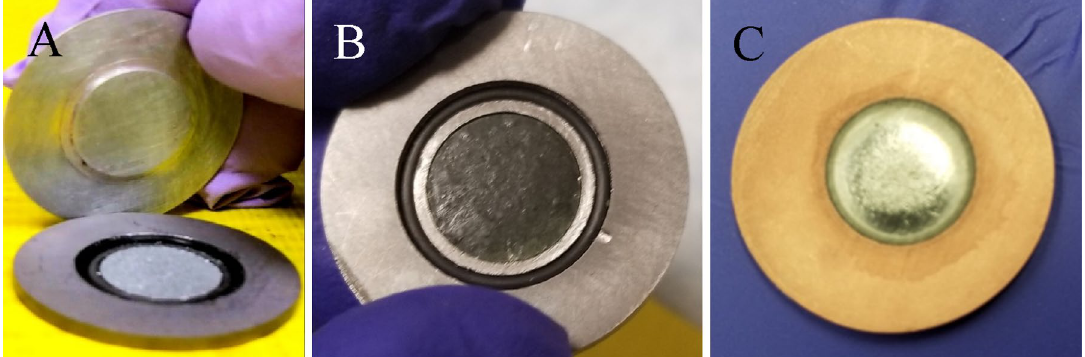
Figure 1. Photos of target configurations described before irradiation. ( A ) Cr metal powder target with Al “push button” degrader, ( B ) Cr 2 O 3 target, ( C ) electroplated Cr(III)